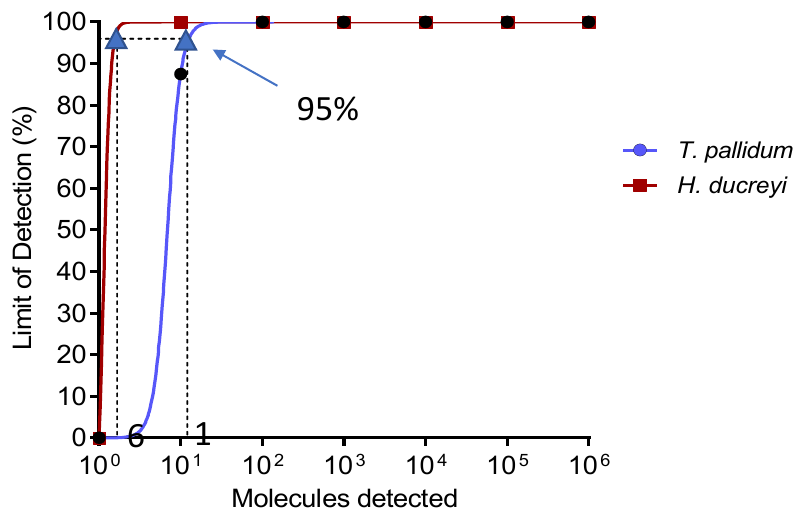
Figure 2. Probit regression analysis. The limit of detection at 95% probability is 11 and 6 DNA molecules for T. pallidum and H. ducreyi , respectively. CI: confidence interval.